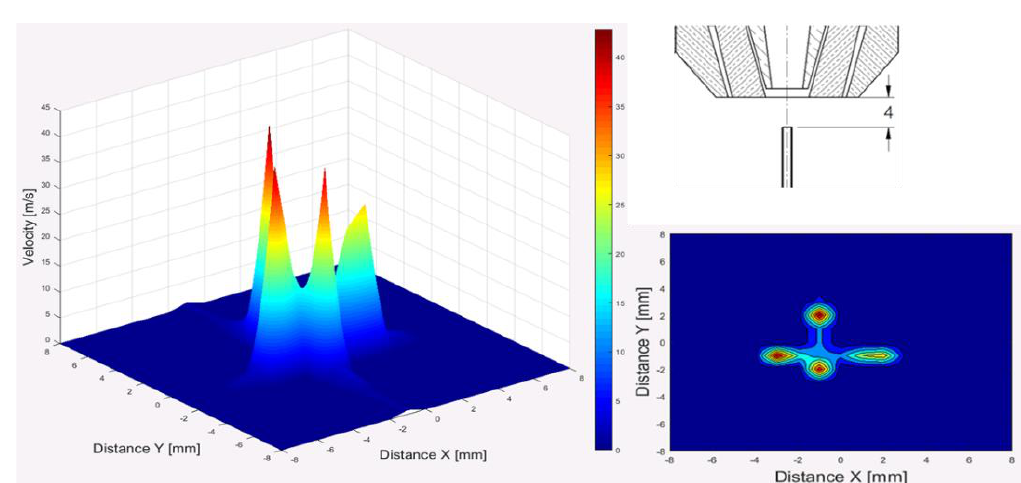
Figure 14: gas velocity measured at 4 mm from the nozzle